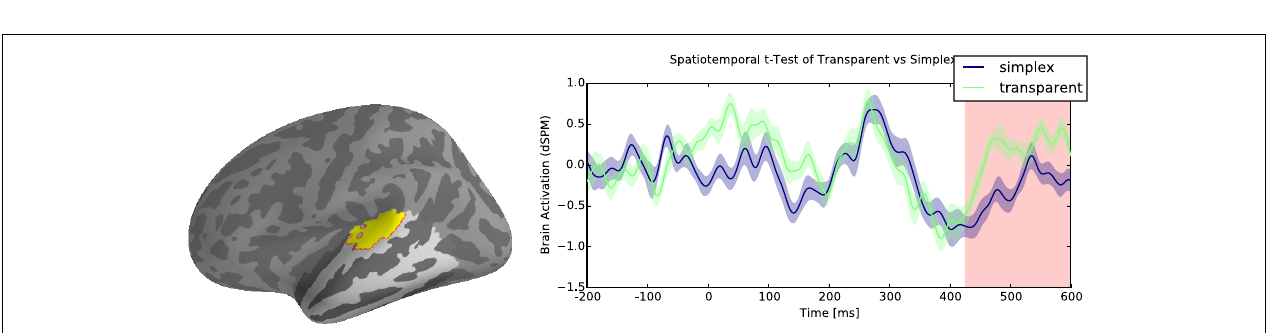
FIGURE 3 | Transparent vs. simplex difference in Left Anterior Temporal Lobe (LATL).